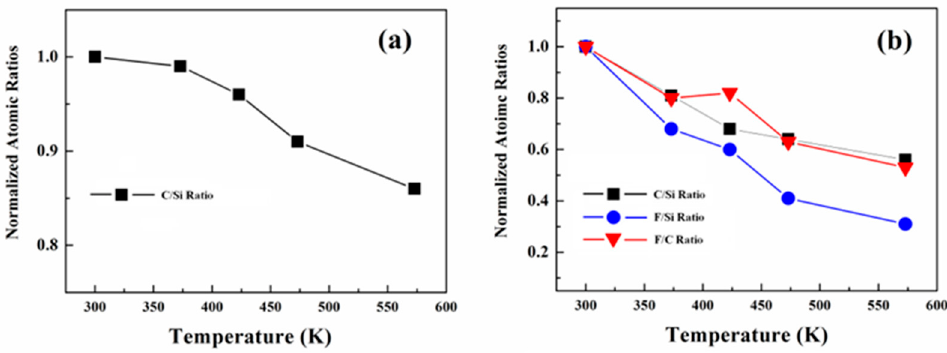
Figure 4. Atomic ratios determined from XPS of ( a ) OTS / SiO 2 and ( b ) PTES / SiO 2 samples as a function of vacuum annealing temperature.